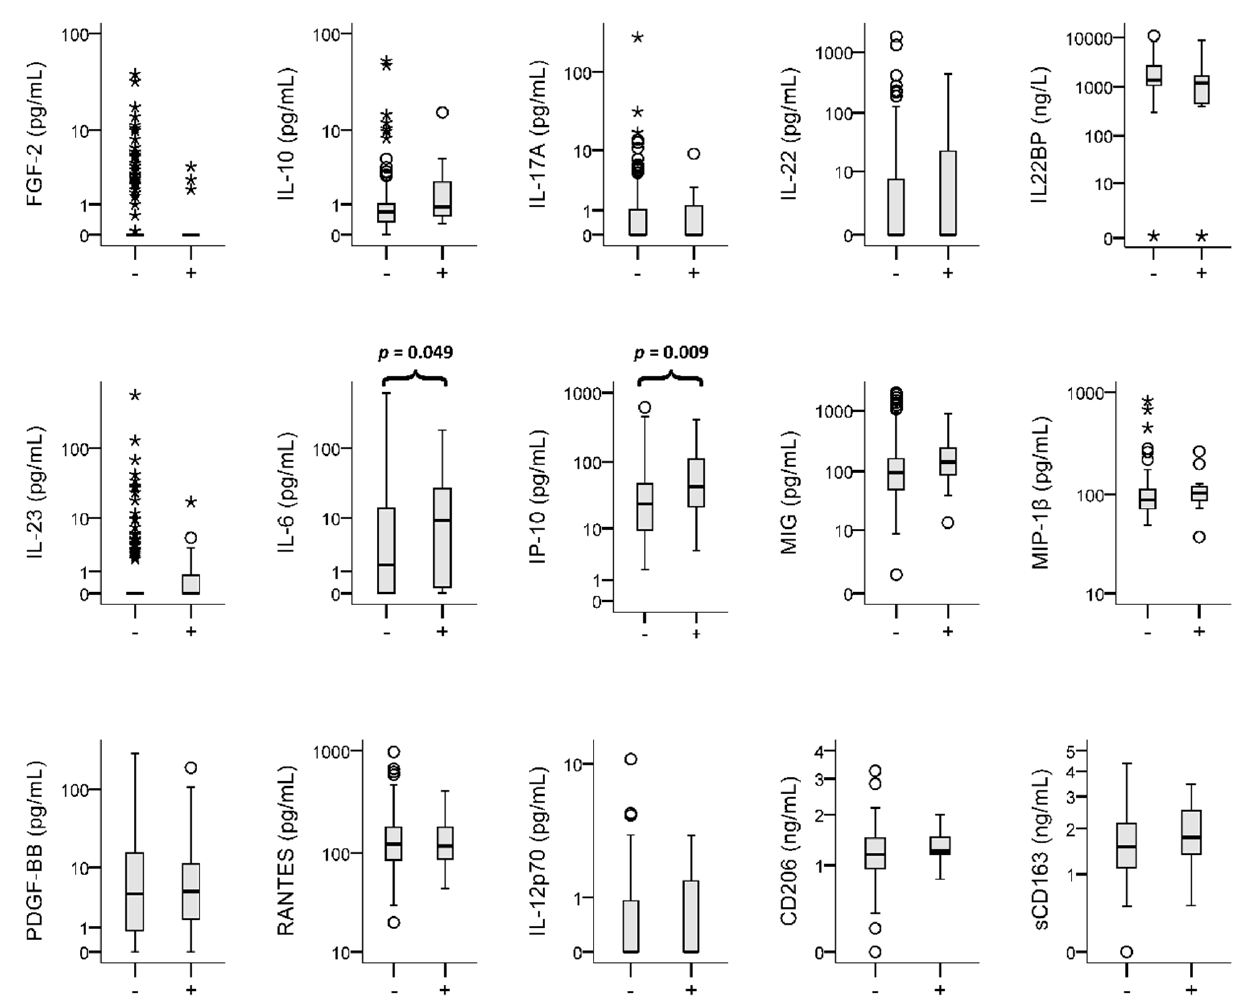
Figure 2. Box plots for cytokines. The box plot visualizes the following summary statistics: the middle line represents the median; the lower hinge corresponds to the first quartile (25th); the upper hinge corresponds to the third quartile (75th); upper and lower whiskers extend from the hinge respectively to the largest value and smallest value or no further than 1.5 × interquartile range; data beyond the whiskers are outliers (circles) and extremes (asterisks). Outliers are at least 1.5 box lengths from the median and extremes are at least three box lengths from the median.